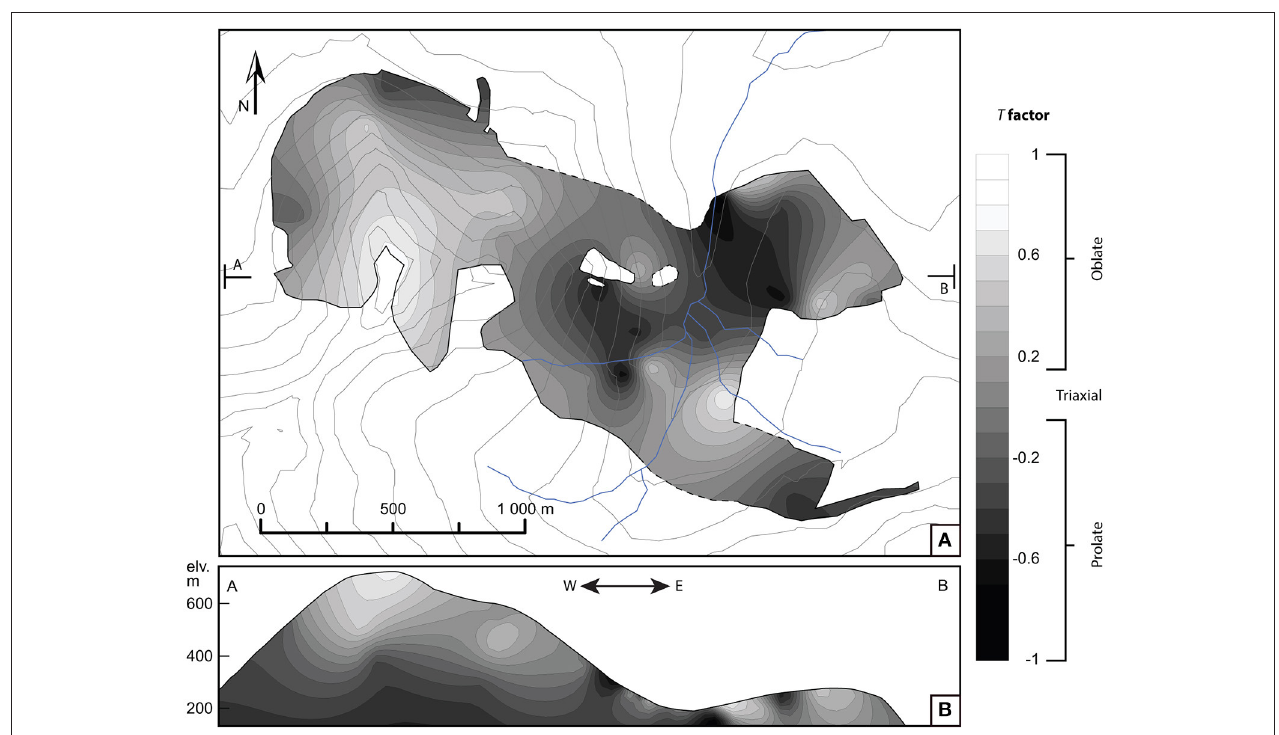
FIGURE 8 | Contoured map and cross-section of the shape factor T of the measured anisotropy of magnetic susceptibility in samples from across the laccolith. (A) In the western part of the main body of the Sandfell laccolith, the magnetic fabric is dominantly oblate, while dominantly prolate in the eastern part. See Figure 7B for sample locations. (B) Contoured cross-section of the Sandfell laccolith. The fabric shapes were contoured using elevation and easting position projected onto an E-W cross-section. The cross-section shows a correlation between magnetic fabric shape and elevation in the main body of the Sandfell laccolith.